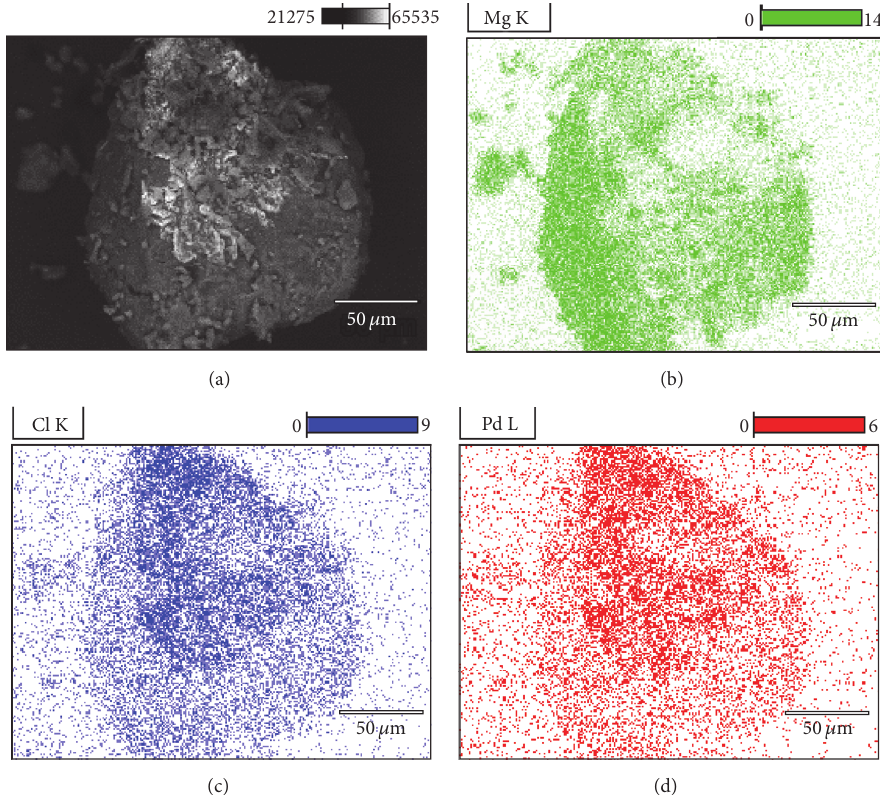
Figure 3: SEM-EDS visualizations for the catalyst of Pd on hydrothermally treated layered double hydroxide. (a) Backscattered electrons image; (b)–(d) EDS mapping of the elements Mg, Cl, and Pd.